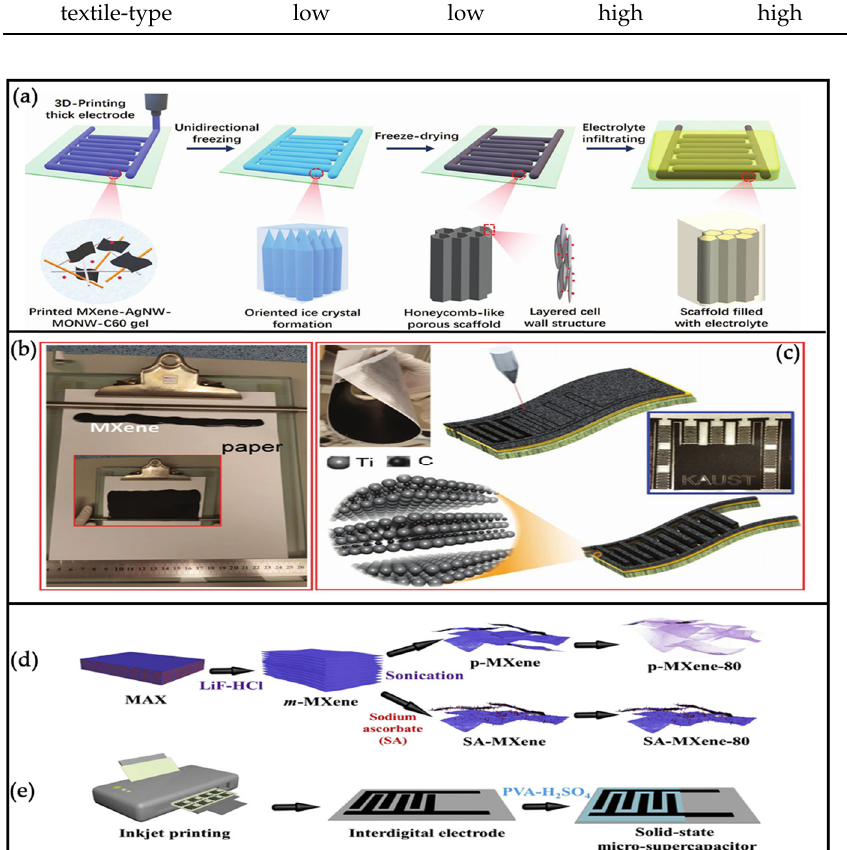
Figure 15. ( a ) Schematic illustration of the fabrication process of intrinsically stretchable MSCs through 3D printing and unidirectional freezing. The 3D-printed thick interdigitated electrodes possess a honeycomb-like porous structure in combination with a layered cell wall architecture. Reprinted with permission from Ref. [187]. Copyright 2020 WILEY-VCH Verlag GmbH & Co., KGaA. ( b ) MXene slurry on an A4 sheet of printing paper with Meyer rod; the inset shows a snapshot of the progression of the coating process. ( c ) Foldable MXene/paper, schematic illustration of laser patterning of MXene-coated paper to fabricate interdigitated electrodes for MSCs, and fabricated MXene-based MSC device along with the crystallographic arrangement of Ti (gray color) and C (black color) atoms in MXene sheets. Reprinted with permission from Ref. [188]. Copyright 2016 WILEY-VCH Verlag GmbH & Co., KGaA. ( d ) Schematic representation of the synthesis of a stable SA-MXene nanocomposite. ( e ) Schematic representation of a solid-state MSC fabricated through the inkjet printing of SA-MXene nanocomposites. Reprinted with permission from Ref. [189]. Copyright 2019 Energy Storage Materials